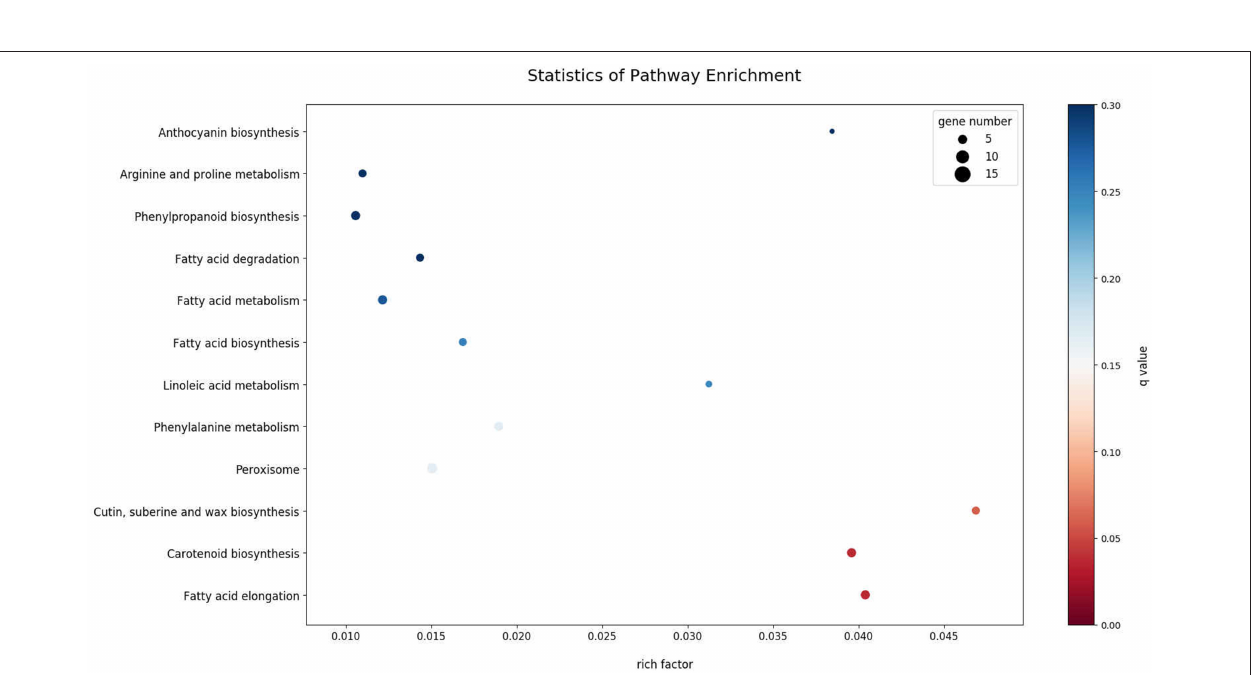
FIGURE 2 | KEGG Enrichment Scatter Plot of the 15 most enriched pathways. The 15 most significantly DEG-enriched pathways (padj < 0.05) are displayed on the y-axis and their associated level of enrichment is displayed along the x-axis. The degree of KEGG enrichment is measured by rich factor; described as the ratio of the number of DEGs in the pathway compared to the total number of genes found in the pathway. The greater the rich factor, the greater the degree of gene enrichment. The q -value is the p -value adjusted to sample distribution (also referred to as padj) and indicates significance of pathway enrichment. Smaller q -values indicate more significant levels of enrichment. Dot size represents the number of different genes and the color indicates the q -value.